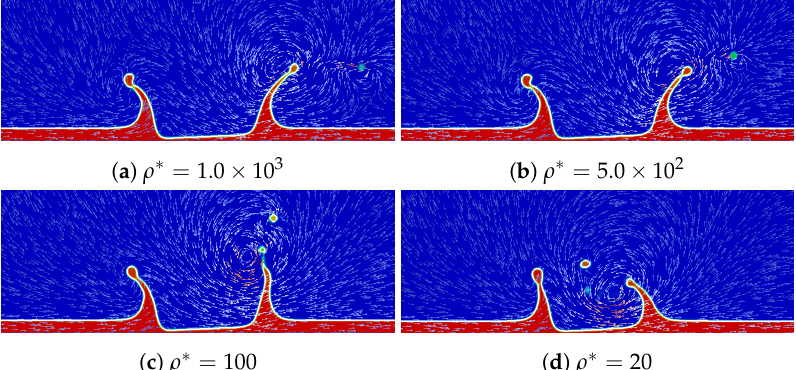
Figure 15. Interface of a drop impact upon a dynamic film at different density ratios when θ = 30 ◦